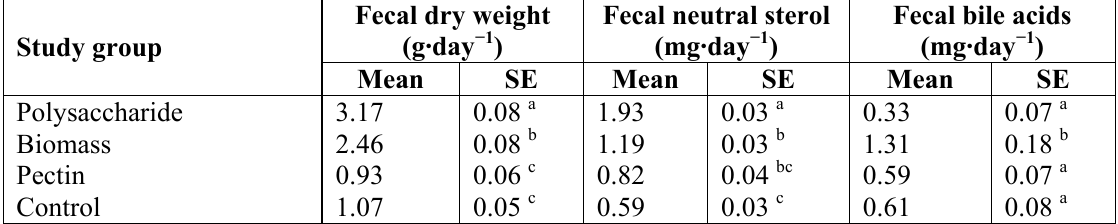
Table 4. Fecal parameters for rats fed experimental diets for 15 days (n = 6). Values in columns with different letters differ significantly, p <